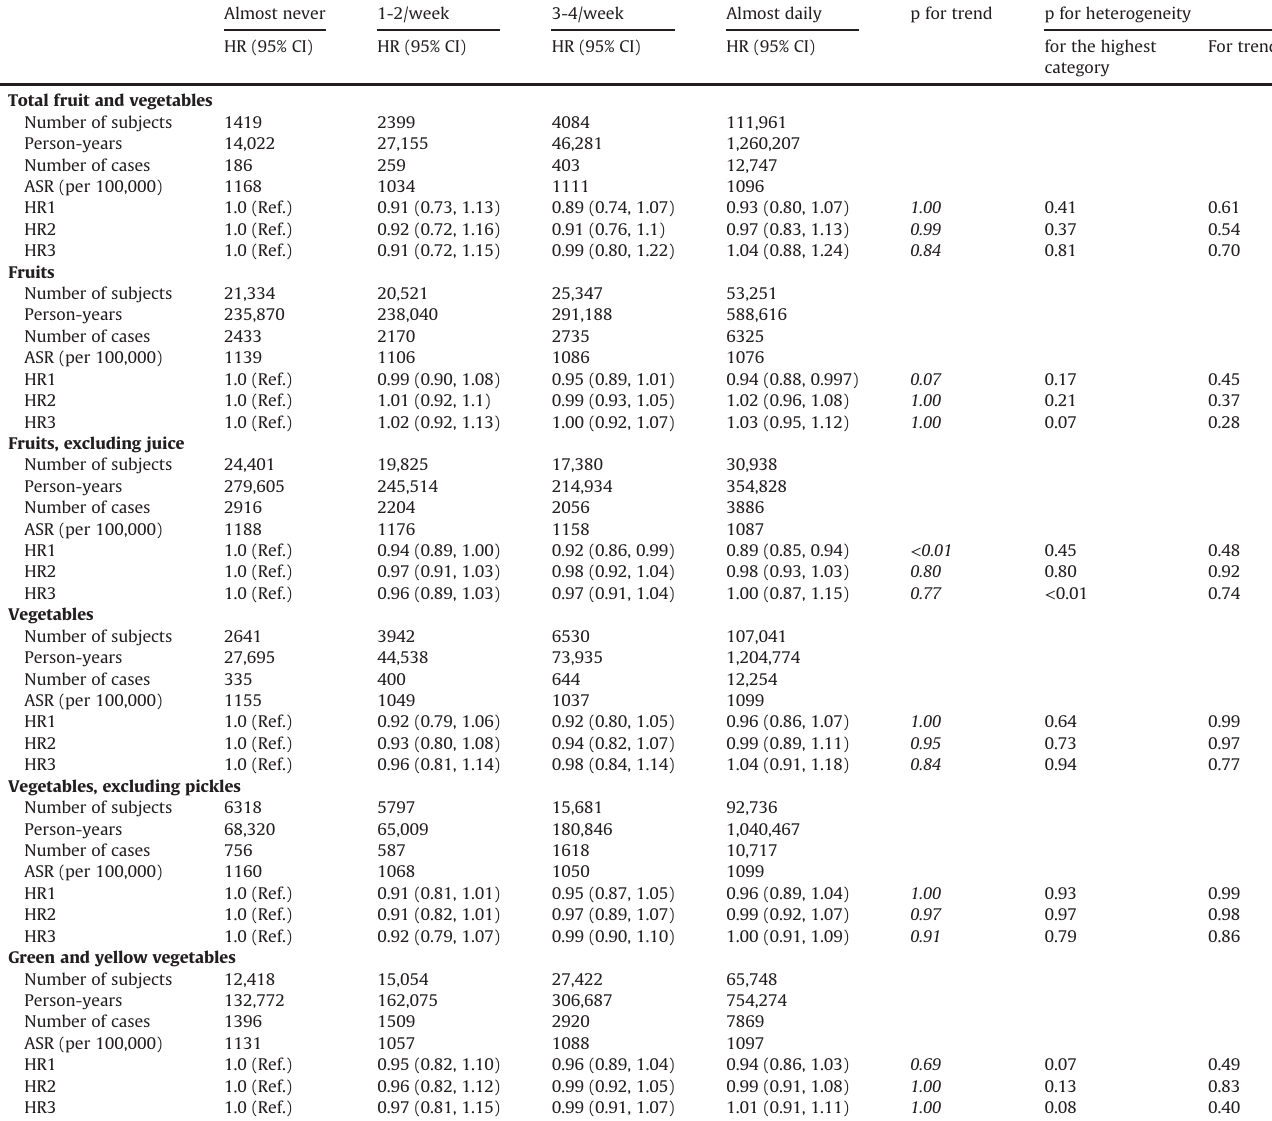
Table 5-1 Pooled analysis of total cancer incidence according to frequency of fruit and vegetable intake among 120,964 Japanese men, 1990 e 2006. Almost never 1-2/week Almost